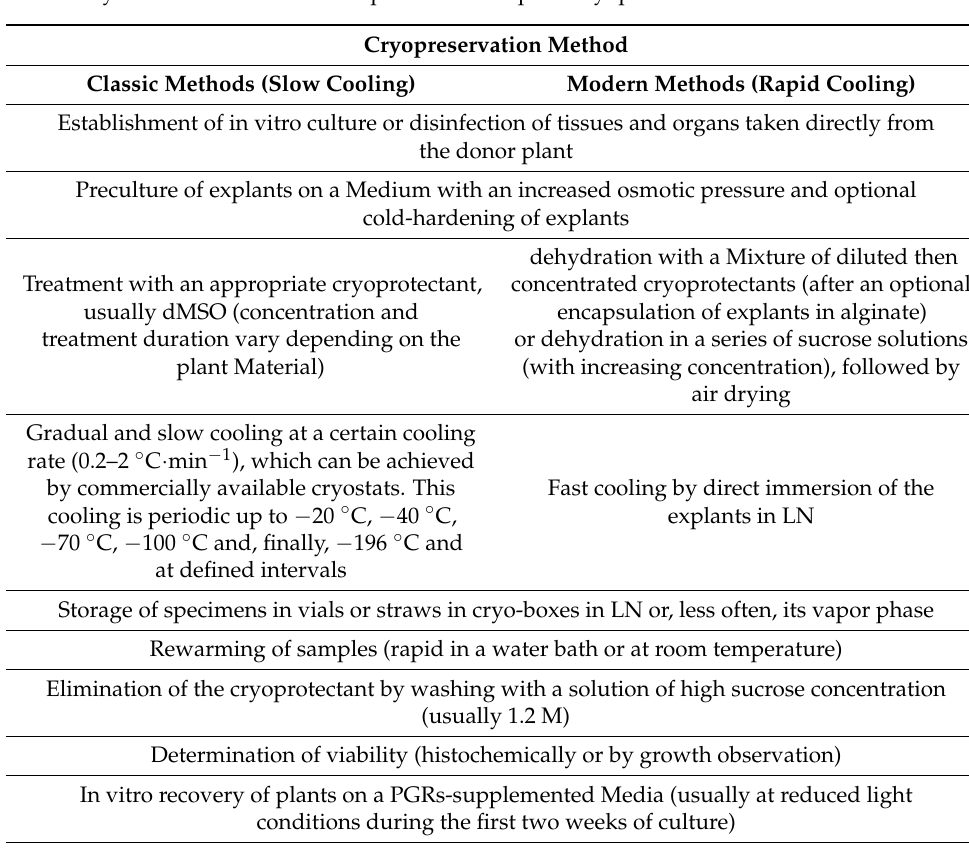
Table 1. Synthesis of the essential steps involved in plant